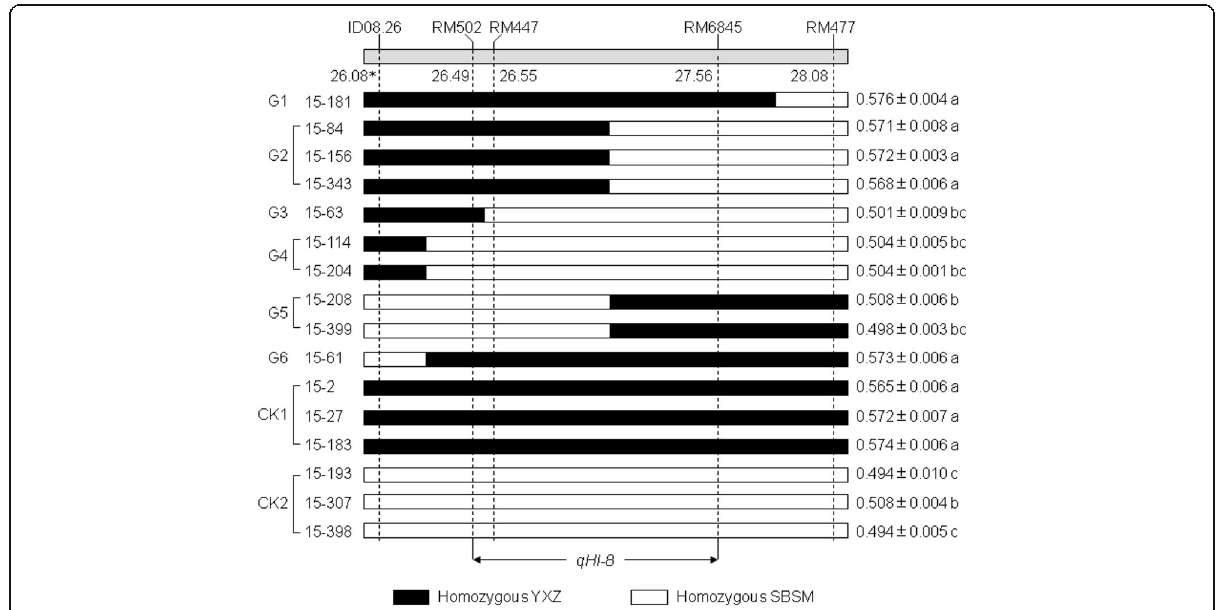
Fig. 3 Delimitation of qHI-8 using the homozygous recombinants. The qHI-8 was delimited to a 1070 kb interval defined by markers RM502 and RM6845. G1 to G6 indicate the recombinants used in this study, consist of six genotypes according to their positions of recombinant breakpoints and allelic composition. Values in the right side are the HI phenotypes of each recombinant and the controls, CK1 and CK2 (mean ± SD). The values with the same letter indicate no significant difference in HI at p = 0.05 based on Duncan ’ s multiple range test. * The physical position (Mb) of markers on the